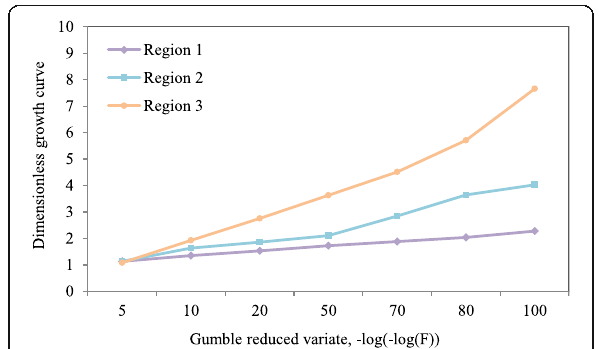
Fig. 7 Estimated regional growth curve for three homogeneous